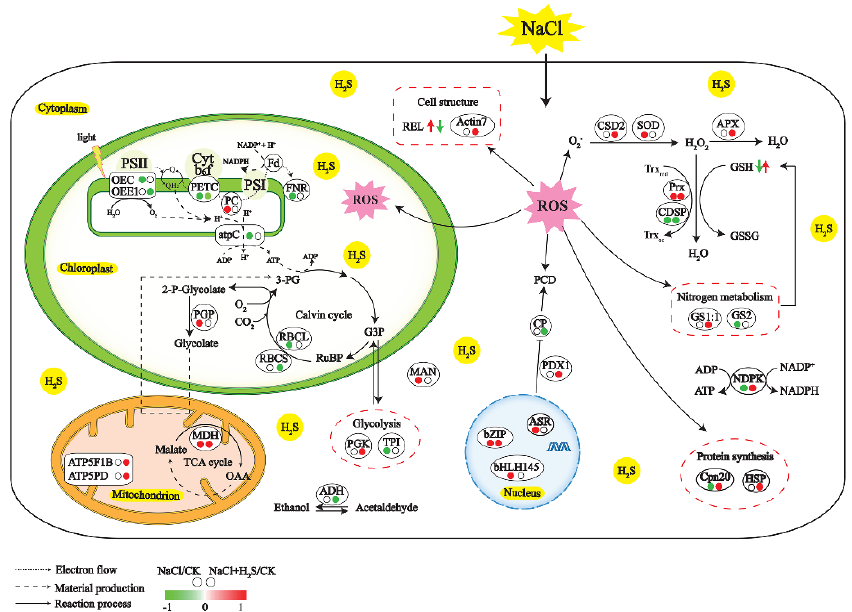
Figure 7. The proposed regulatory networks of H 2 S on the salt tolerance of K. obovata seedling leaves. The left and right dots stand for the NaCl and NaCl and H 2 S treatments, respectively. The red color of dot indicates the up-regulated change, the green color of dot indicates the down-regulated change, and the white color of dot indicates no change in comparison to the control. The left and right arrows stand for the NaCl treatment and the NaCl and H 2 S treatment, respectively. The red color arrow indicates physiological indexes of increased change, and the green color arrow indicates physiological indexes of decreased change. ADH: alcohol dehydrogenase; APX: cytosolic ascorbate peroxidase; Asr: abscisic acid stress ripening protein; atpC: ATP synthase CF1 epsilon subunit; ATP5F1B: ATP synthase beta subunit; ATP5PD: ATP synthase subunit d, mitochondrial; CP: cysteine proteinase; Cpn 20: